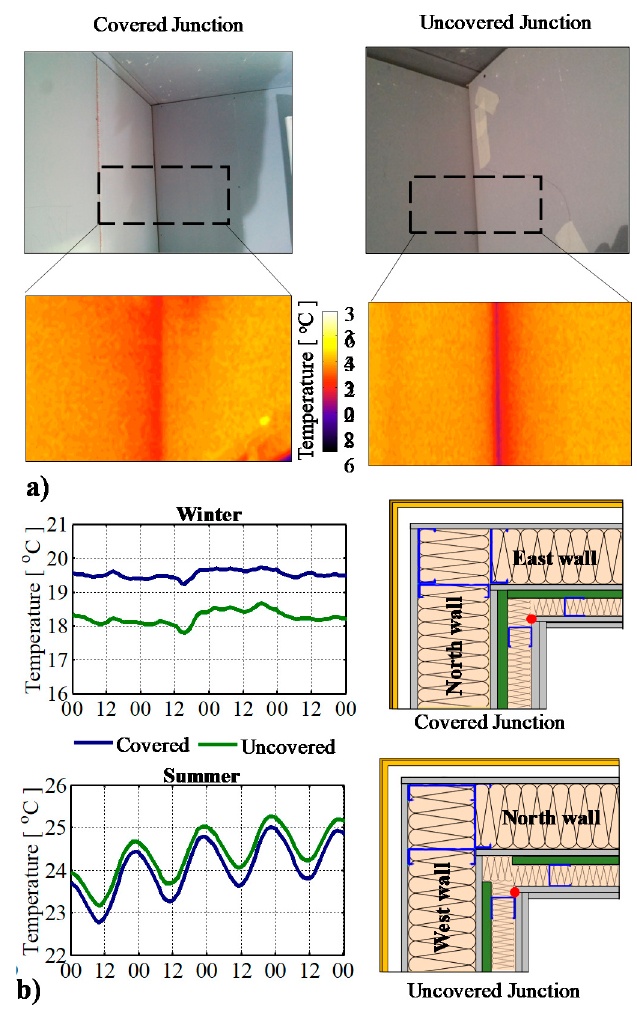
Figure 7. Junctions covered and not covered with VIPs: ( a ) Infrared thermography and ( b ) temperatures at the interface between the internal gypsum board and the 50 mm thick mineral wool (MW50) during winter and summer.